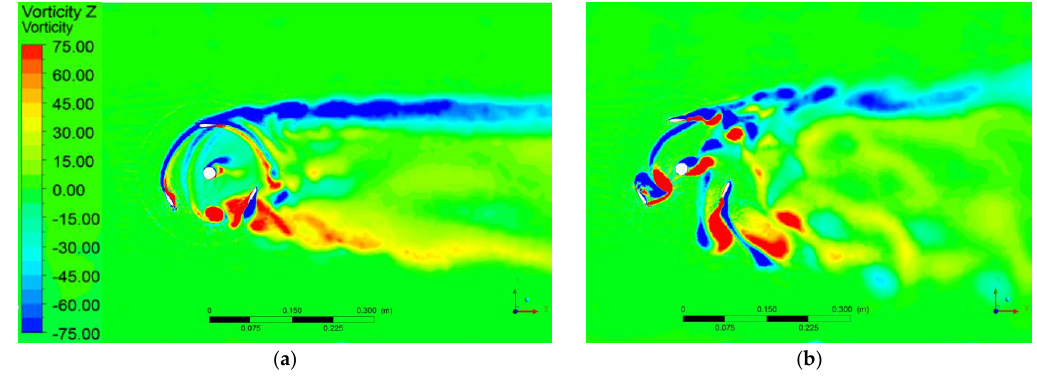
Figure 13. Instantaneous field of vorticity on symmetry plane for ( a ) λ = 1 and ( b ) λ = 2 for the URANS model. Energies 2018 , 11 , x